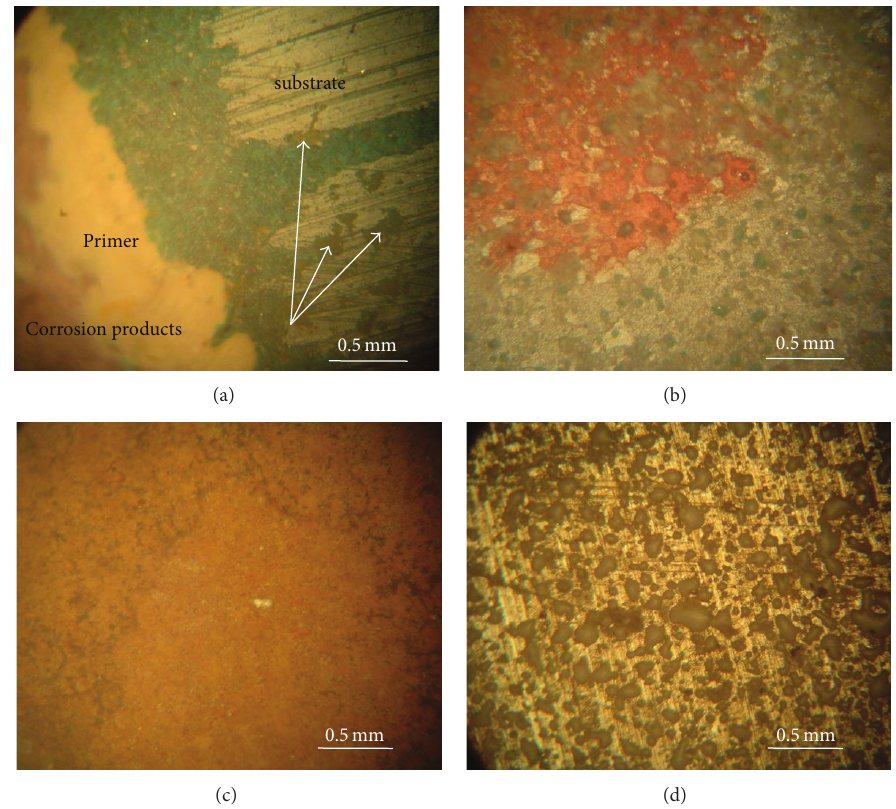
Figure 5: Optical micrographs of corroded surface after 15 days of exposure in 5% NaCl solution: (a) primed steel, (b) hot-dip galvanized steel, (c) steel, and (d)